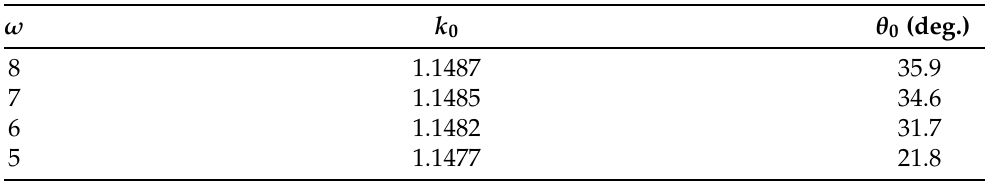
Table A1. Convergence of the position ( k 0 , θ 0 ) of the zero in f Ps with respect to variations in ω for the s -wave only. For the p -, d - and f -wave, ω is 6, 5 and 4, respectively. ω k 0 θ 0